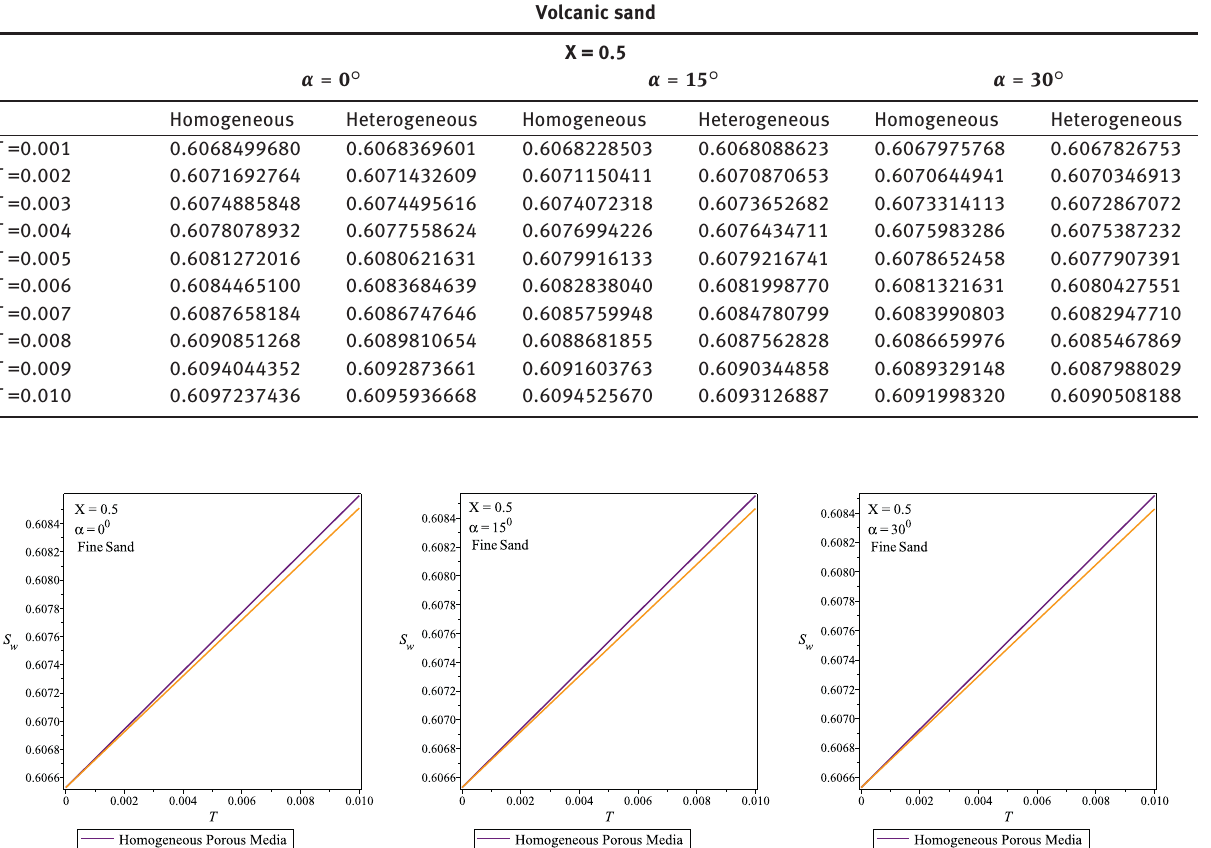
Table 3: Saturation of water in Volcanic Sand for Homogeneous and Heterogeneous Inclined Porous Media